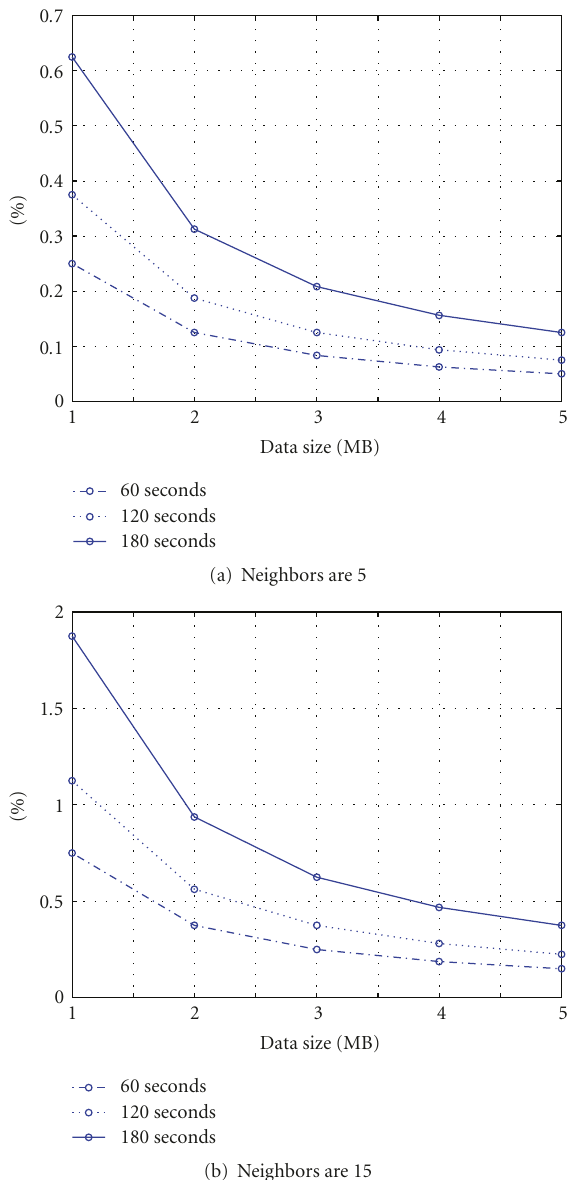
Figure 13: The percentage of the trajectory information exchange over the data need to be transferred to the collector node’s near likely user under various data size in the walking scenario for two network sizes: (a) neighbors are 5; (b) neighbors are 15.